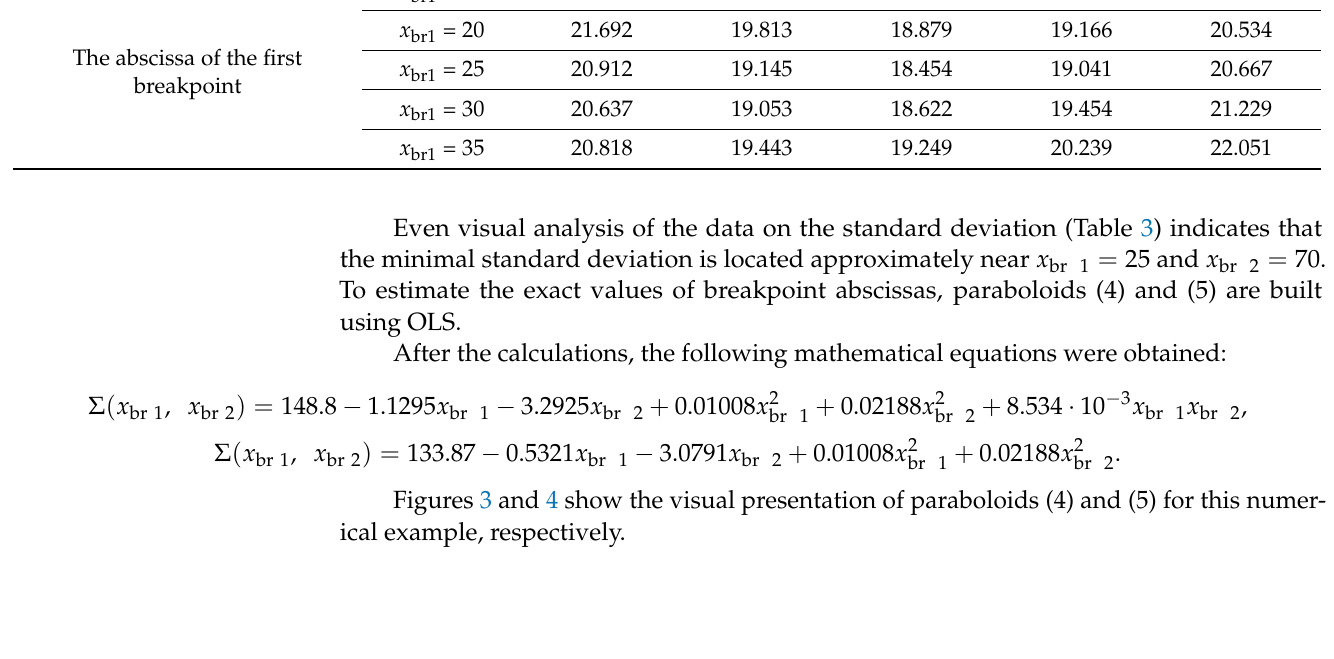
Table 3. Computation results for standard